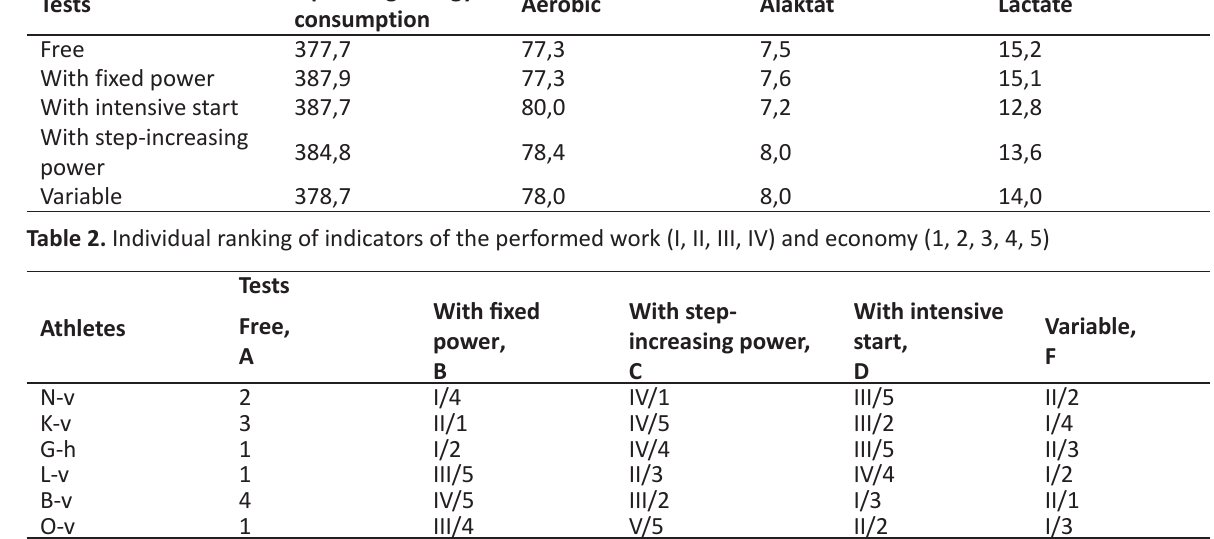
Table 1. Total energy expenditure (KJ) ratio of various components of energy production (%)